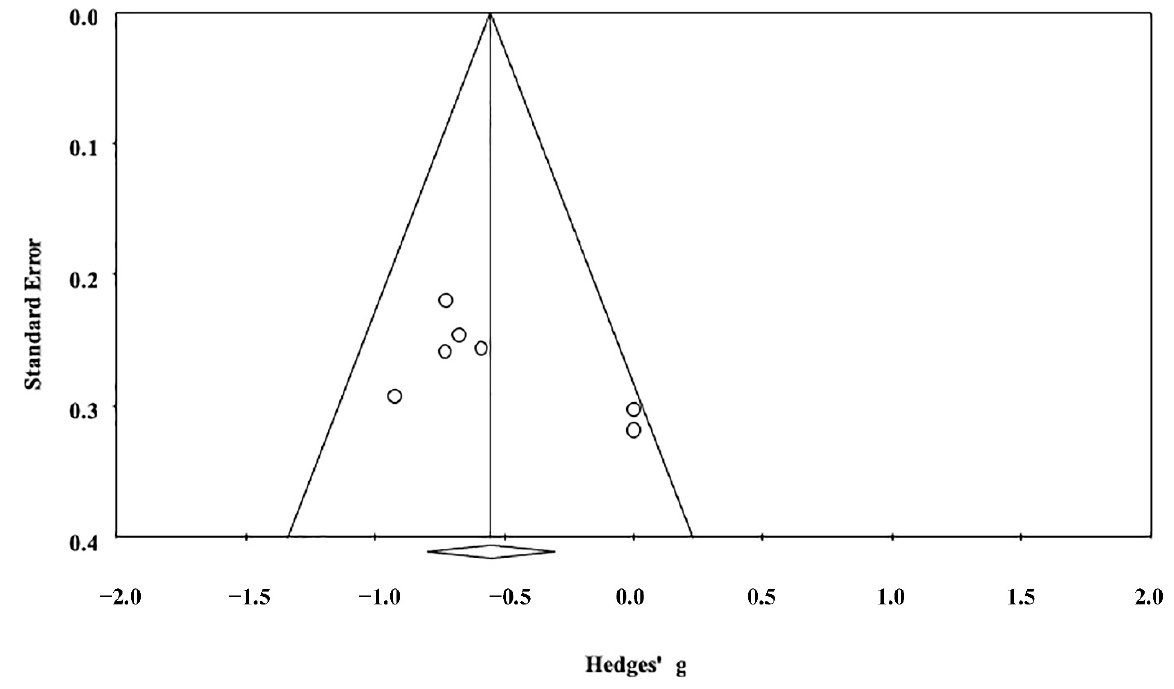
Figure 3. Random-effects funnel plot for detecting publication bias in studies reporting the brain volumes between individuals with excessive smartphone use and their comparators with regular use. Table 2. Comparison of brain volumes between individuals with excessive smartphone use and their counterparts with regular use: Hedges’ g .